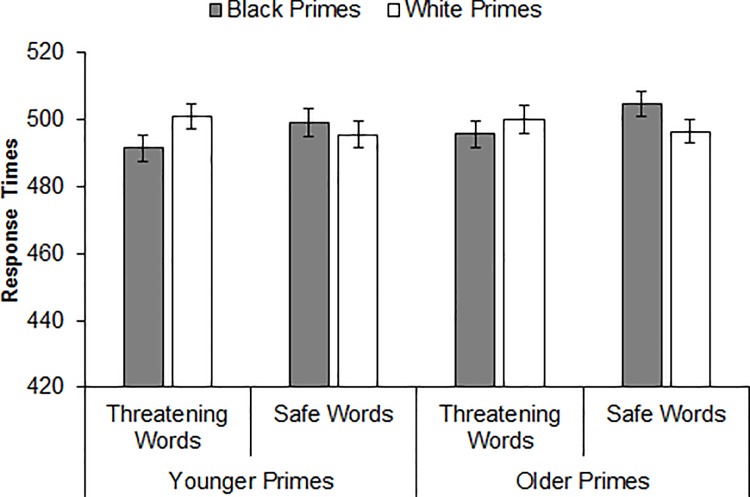
Mean response times (in milliseconds) for threatening and safe word identifications by prime race and prime age (Experiment 2).